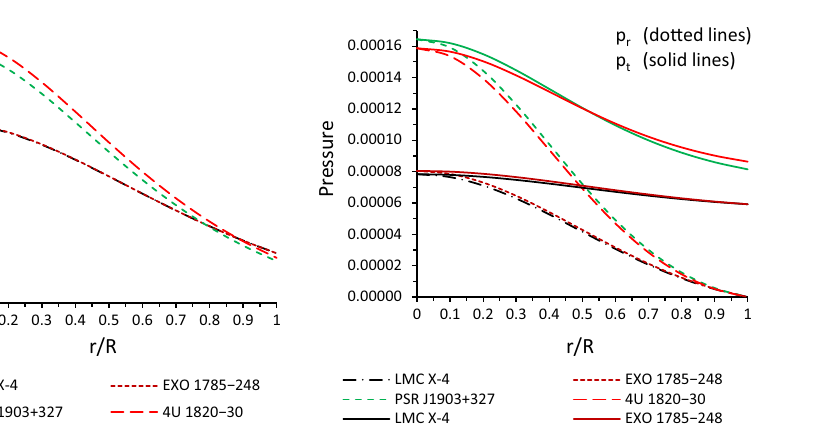
Fig. 1 Behaviour of gravitational potential e ν ( left panel ) and e λ ( right panel ) vs. fractional radius r / R for LMC X-4, EXO 1785-248, PSR J1903+327 and 4U 1820-30. For plotting this figure the numerical val- ues of physical parameters and constants are as follows: (i) a = 0 . 004, b = 0 . 0021, c = 0 . 0107, A = 0 . 4806, B = 1 . 2607, M = 1 . 29 M (cid:7) , and R = 8 . 831 km for LMC X-4, (ii) a = 0 . 00393, b = 0 . 0025,